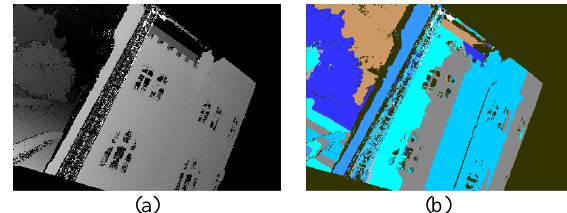
Figure 3. Example of the initial segmentation of the disparity map using the histogram and region